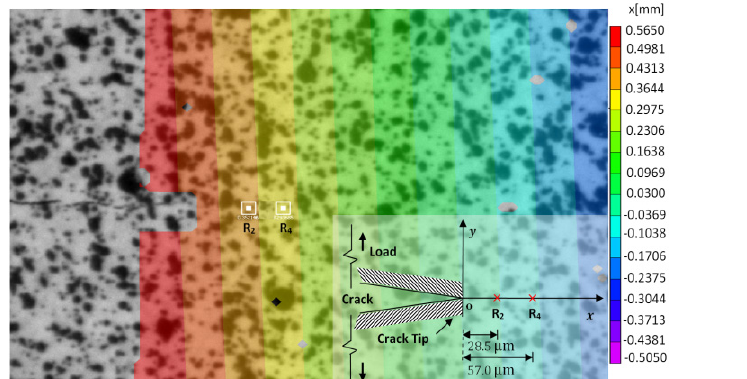
Figure 2: The random speckle pattern on the specimen and a typical displacement map extracted from the DIC measurement. The locations of R 2 and R 4 are illustrated with respect to the crack